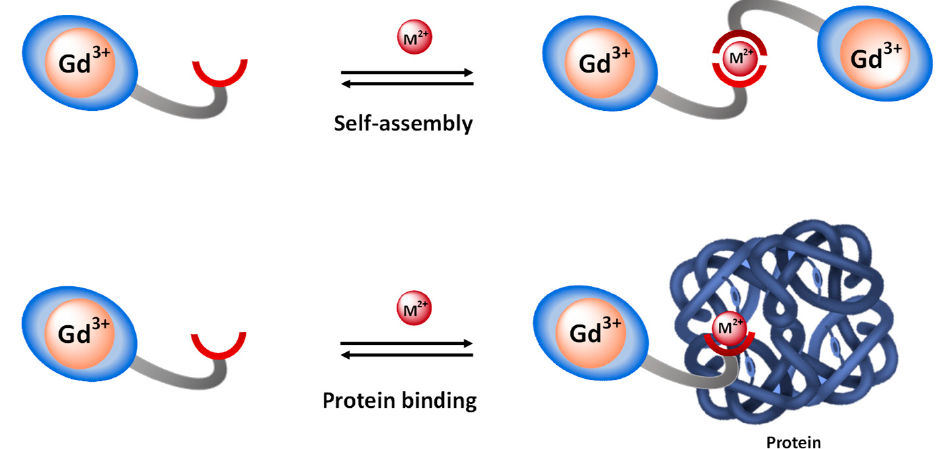
Figure 3. Principle of cation detection by τ R -modulation, achieved by either self-assembly or by protein binding.